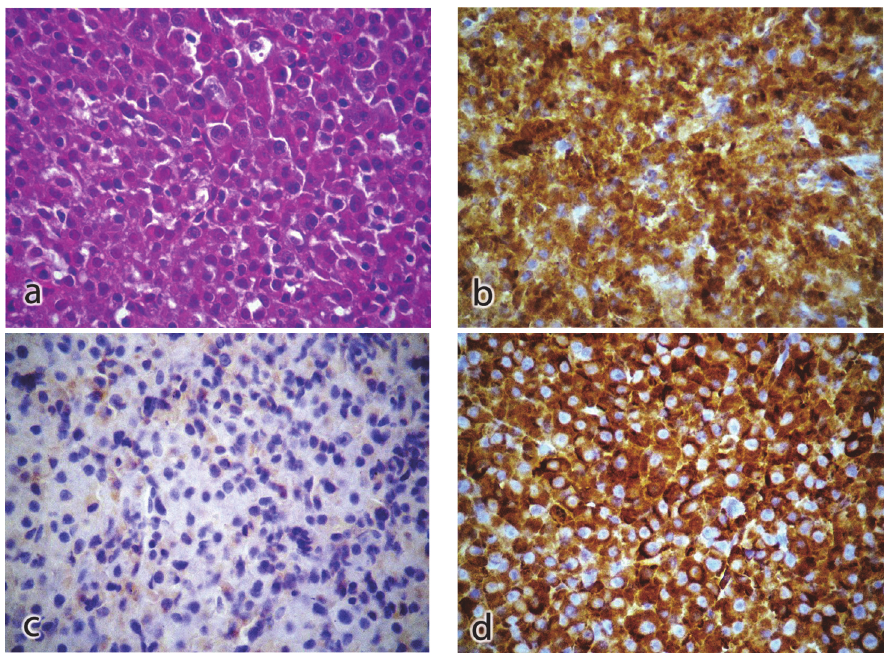
Figure 3: Microscopic examination revealed a plasma cell tumor. The histological sections showed lymphoid origin of tumor fragment characterized by the proliferation of atypical plasma cells which are arranged in sheets (a, HE); immunohistochemical reactions were positive for plasm cell (b); negative for kappa (c); and positive for lambda